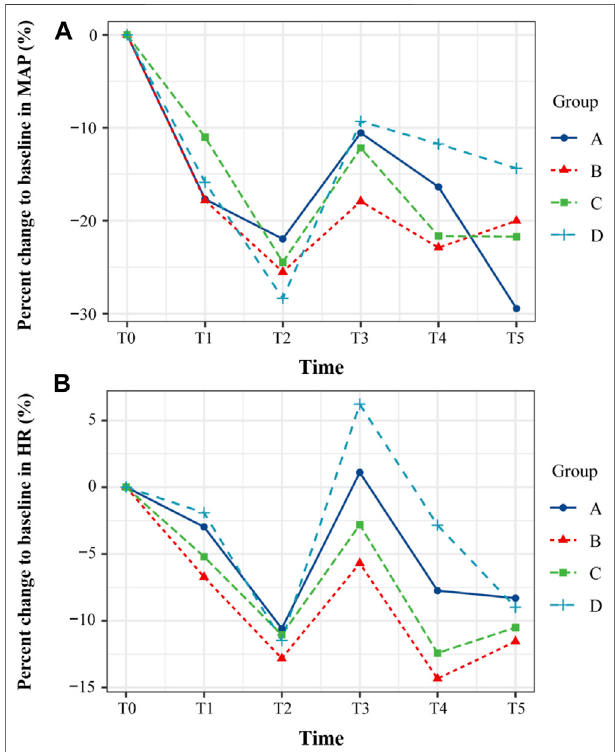
FIGURE 2 | The changes of hemodynamic parameters at fi ve different time points during the induction of anesthesia. (A) Mean arterial pressure (MAP). (B) Heartrate(HR).ThepercentchangesofMAPandHRrelativetothe baseline between the four groups were compared. All the values are presented as mean. T0, before propofol administration; T1, LOC; T2, 3 min after the administration of fentanyl and cisatracurium; T3, 1 min after intubation; T4, 5 min after intubation; T5, 10 min after